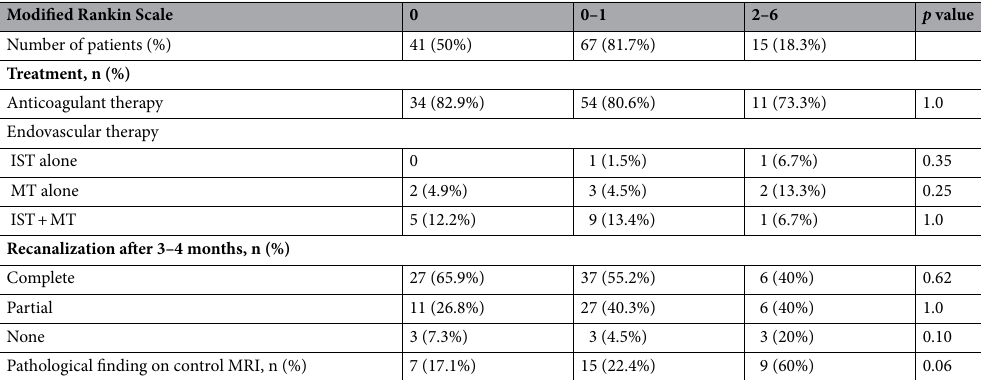
Table 2. Treatment and achieved recanalization in the groups according to the clinical outcome. Values are expressed as n (%). Fisher’s exact test was used for calculation of p values of categorical data. IST intrasinus thrombolysis, MRI magnetic resonance imaging, mRS modified Rankin Scale, MT mechanical